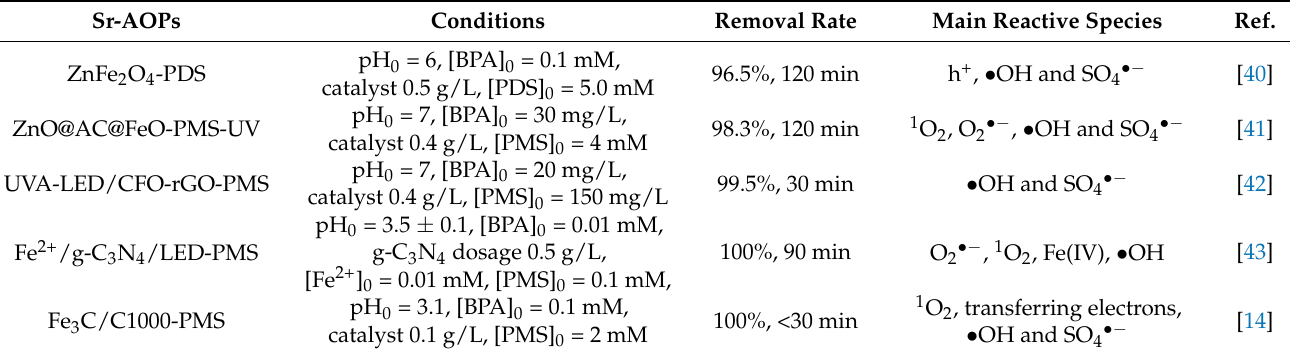
Table 1. Comparison of the BPA degradation efficiency in different Sr-AOPs.